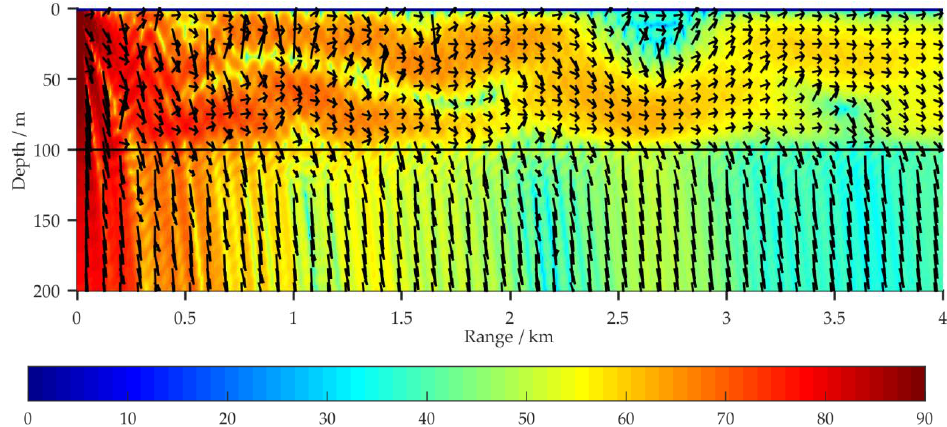
Figure 4. Distribution of acoustic energy flux (SIL) in full waveguide of shallow water for the simulation condition in Figure 2a with Δ H 1 = 100 m.